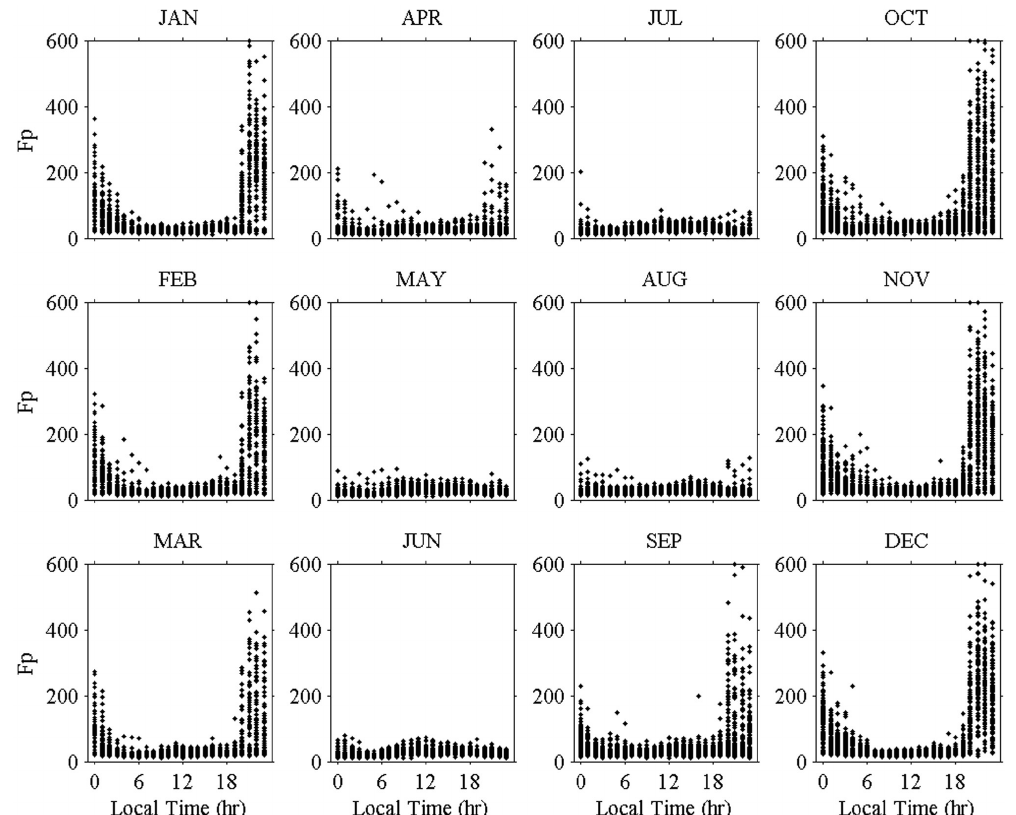
Fig. 6. The diurnal variations of GPS phase fluctuations in various months during 1995–2000 over